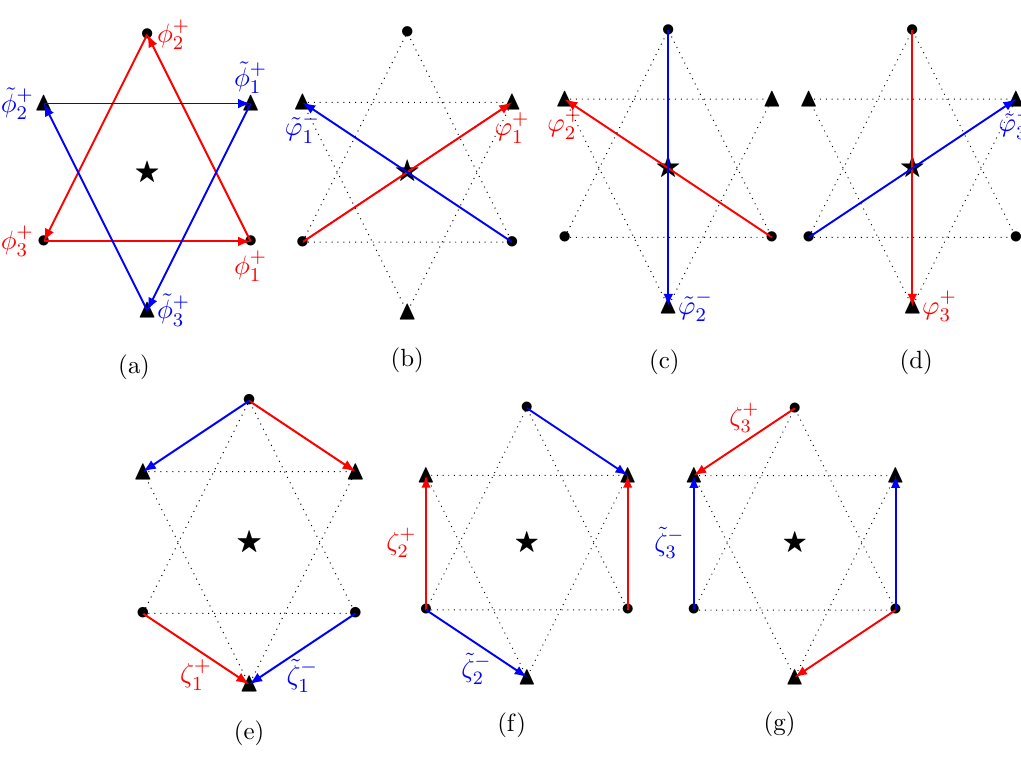
Figure 13. Set-up C [(1 ; 0)] + C [(0 ; 1)] + D . Extremal weights for (1 ; 0) are denoted by (cid:15) , while (0 ; 1) extremal weights are indicated by N , and D is represented by F . The regular intra-brane Higgs modes (cid:30) on C [(1 ; 0)] and ~ (cid:30) on C [(0 ; 1)] are shown in (a). In (b){(d) we display the